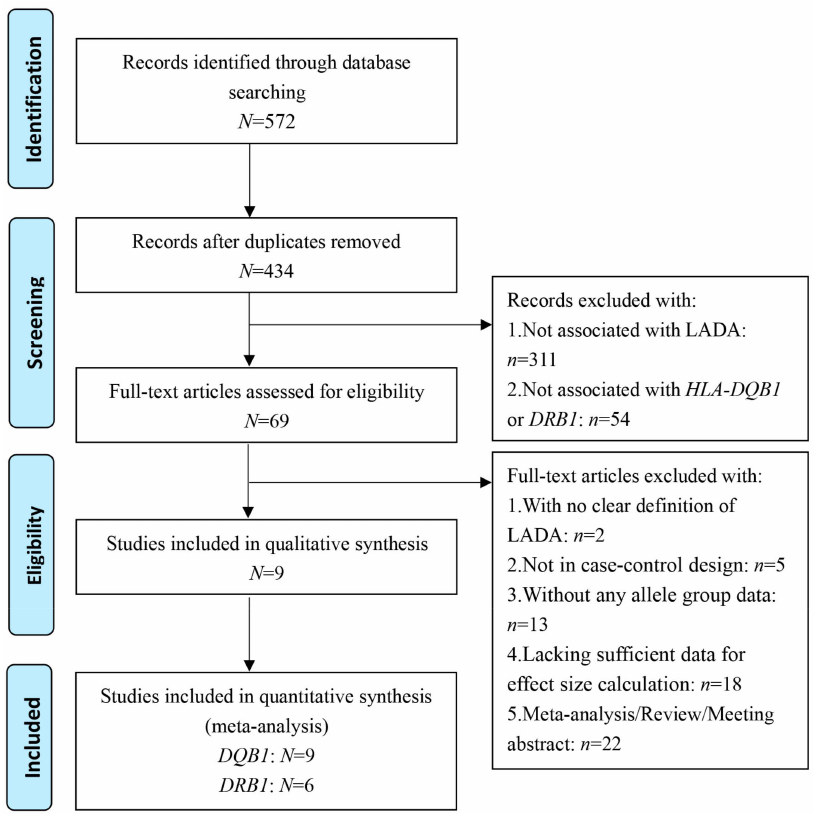
Figure 1. Flow diagram of the process used to select eligible